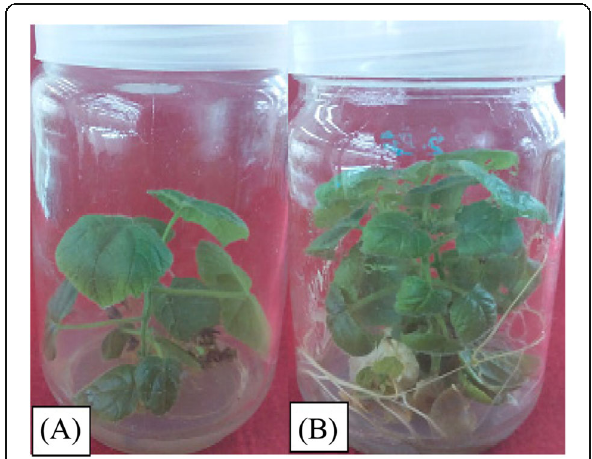
Fig. 1 In vitro propagation of Paulownia tomentosa under the effect of different plant growth regulators (BA, Kin, and IBA) concentrations. a MS free of hormones and b MS + BA at 0.2 mg/l, and Kin and IBA at 0.1